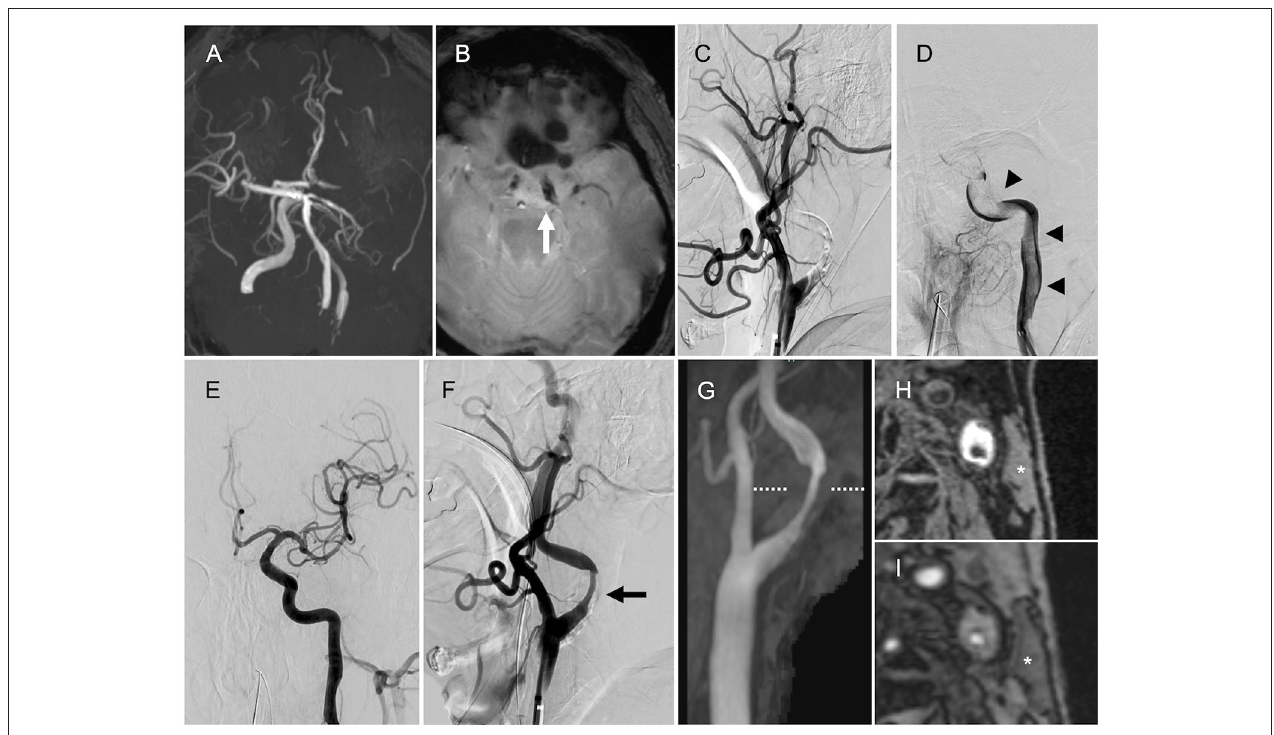
FIGURE 1 | Magnetic resonance imaging (MRI) and angiography findings. (A) Magnetic resonance angiography (MRA) showing the left internal carotid artery (ICA) occlusion. (B) T2*-weighted MRI showing the susceptibility vessel sign at the top of the ICA ( arrow ). (C) Left internal carotid angiography showing the left proximal ICA occlusion (lateral view). (D) Angiography via the aspiration catheter in the cervical ICA showing a continuous filling defect ( arrowheads ) from the cervical ICA to the intracranial ICA (anteroposterior view). (E) Final angiography showing successful reperfusion (anteroposterior view). (F) Final angiography showing the left ICA stenosis ( arrow , lateral view). (G) Neck MRA showing the left ICA stenosis. (H,I) Magnetization-prepared rapid gradient-echo image and maximum intensity projection images from time-of-flight MRA (level of the dotted line) showing high signal intensity in the plaque compared with the sternocleidomastoid muscle ( asterisk